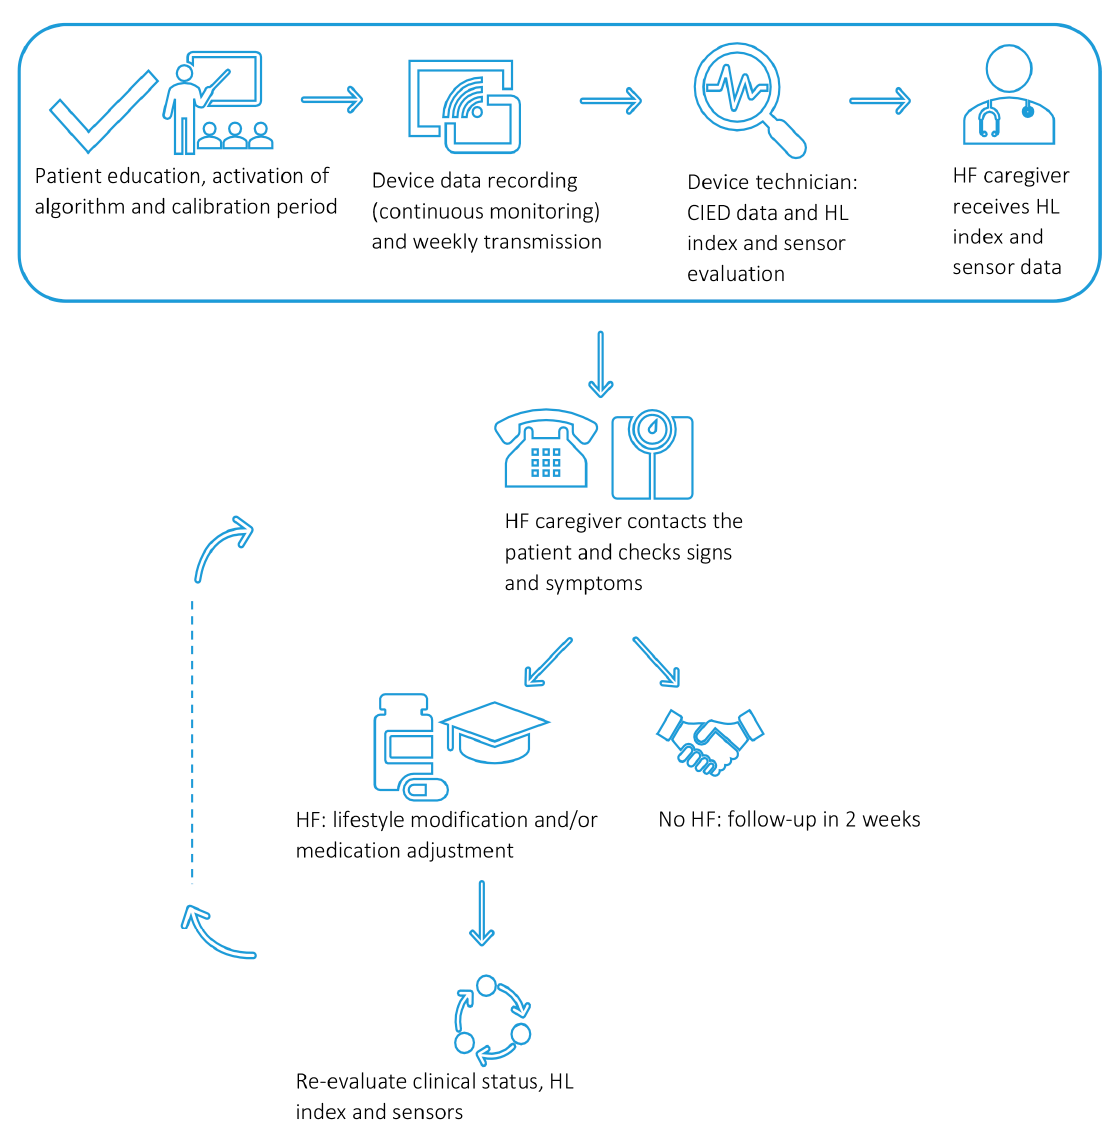
Figure 4. Schematic illustration of how the HeartLogic TM index can be implemented in a clinical care path. HF, heart failure; HL, HeartLogic TM .